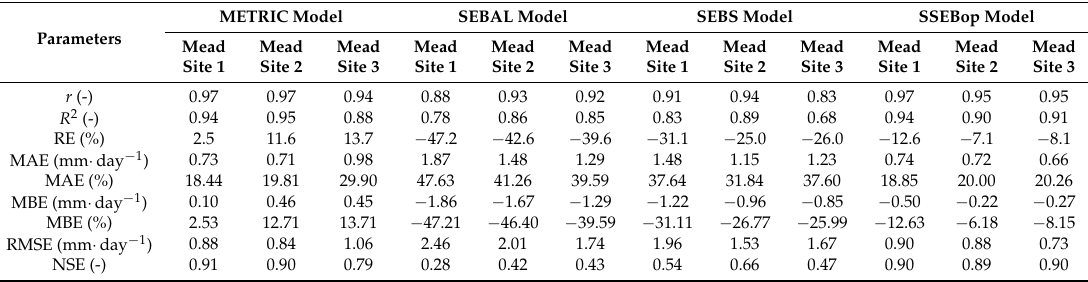
Table 4. Comparison statistics for three flux sites based on Pearson’s correlation coefficient ( r ), coefficient of determination ( R 2 ), relative error (RE), mean absolute error (MAE), mean bias error (MBE), root mean square error (RMSE), and Nash–Sutcliffe’s efficiency (NSE) using the METRIC, SEBAL, SEBS, and SSEBop